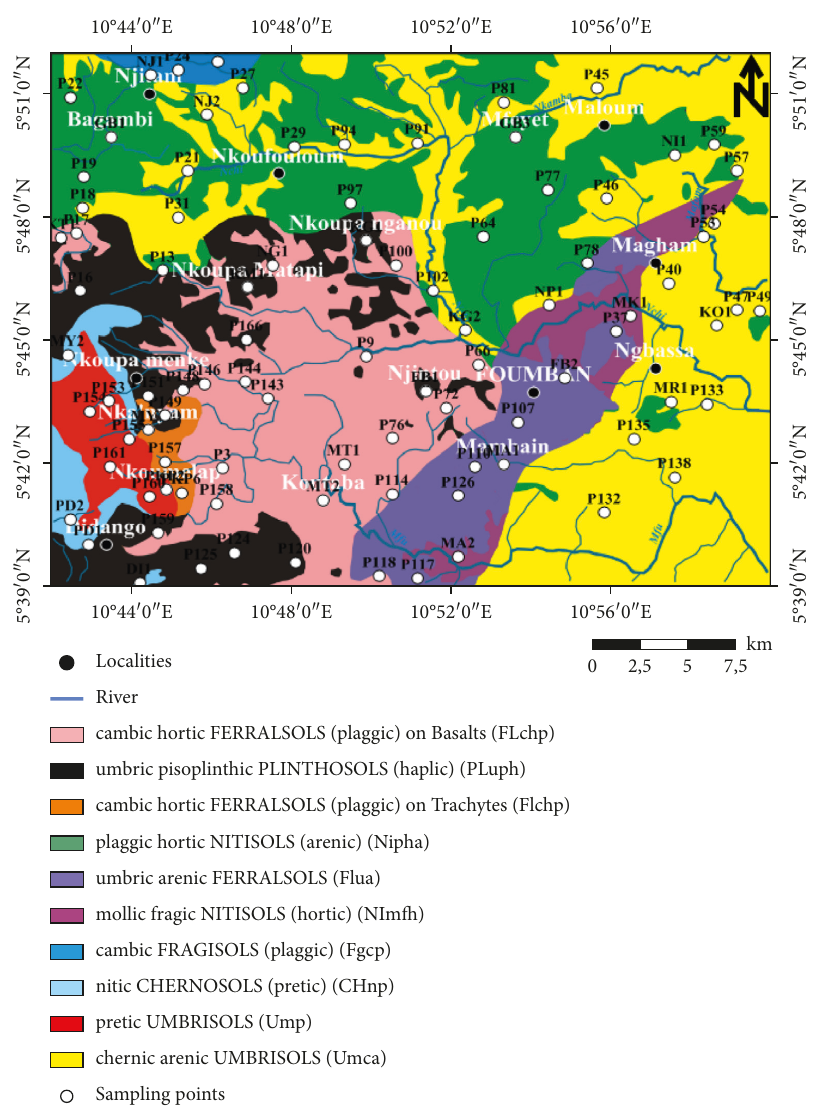
Figure 3: Sampling map with the distribution of soil Table 1: Statistical study of the physical properties of Foumban soil groups.